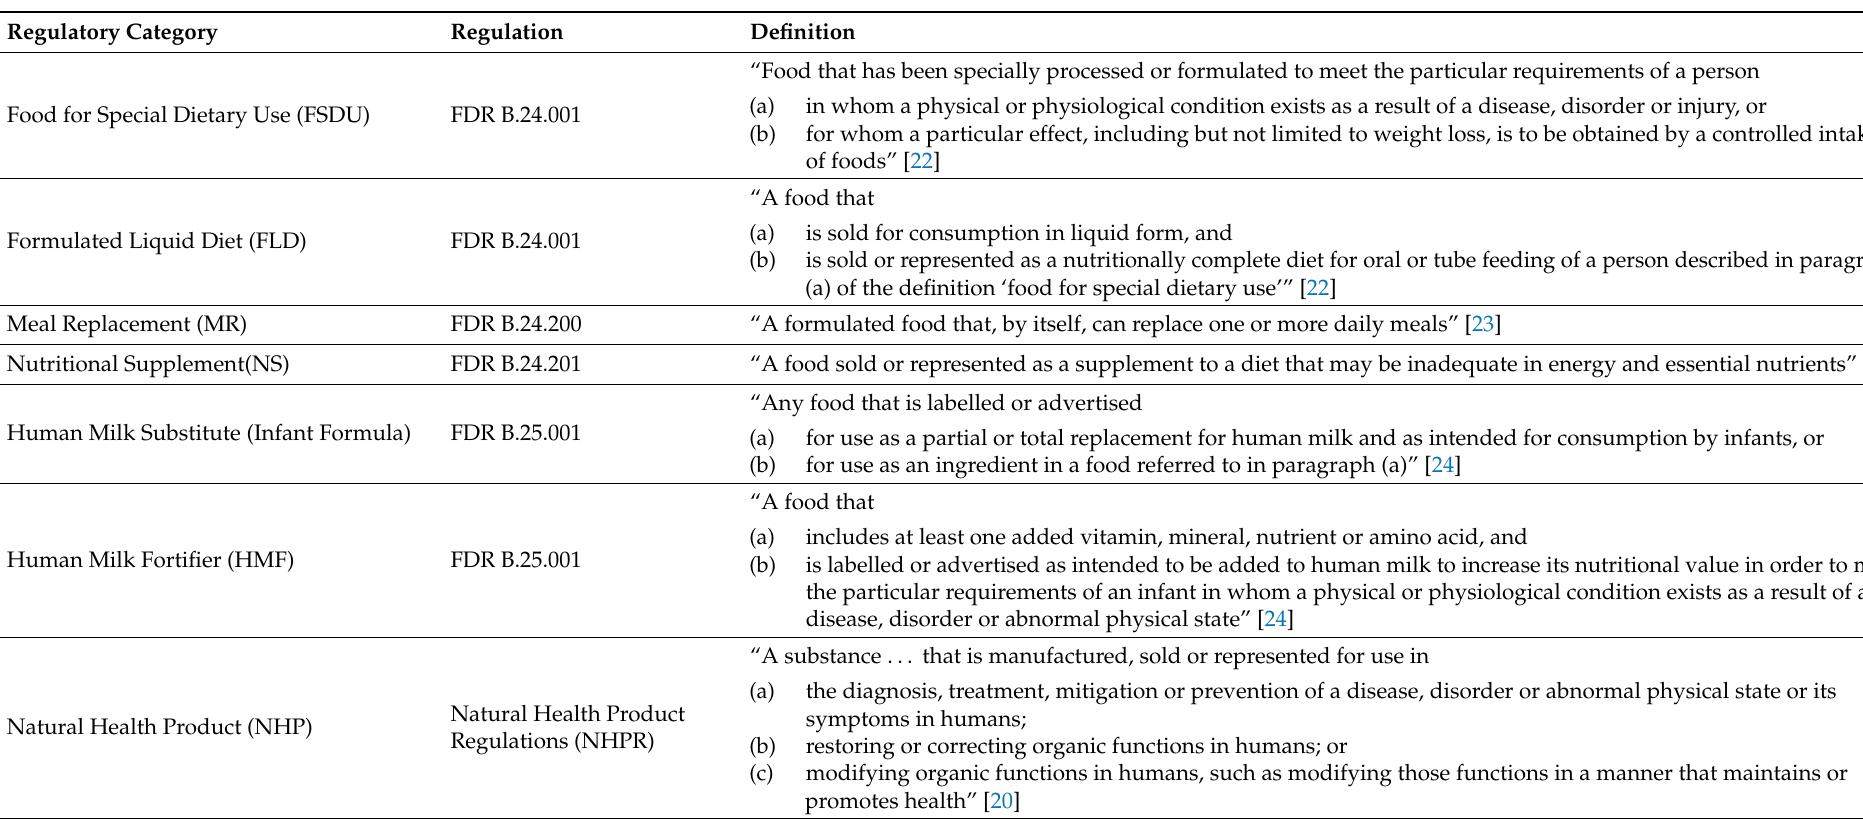
Table 2. Regulatory definitions for select * specialized product categories in